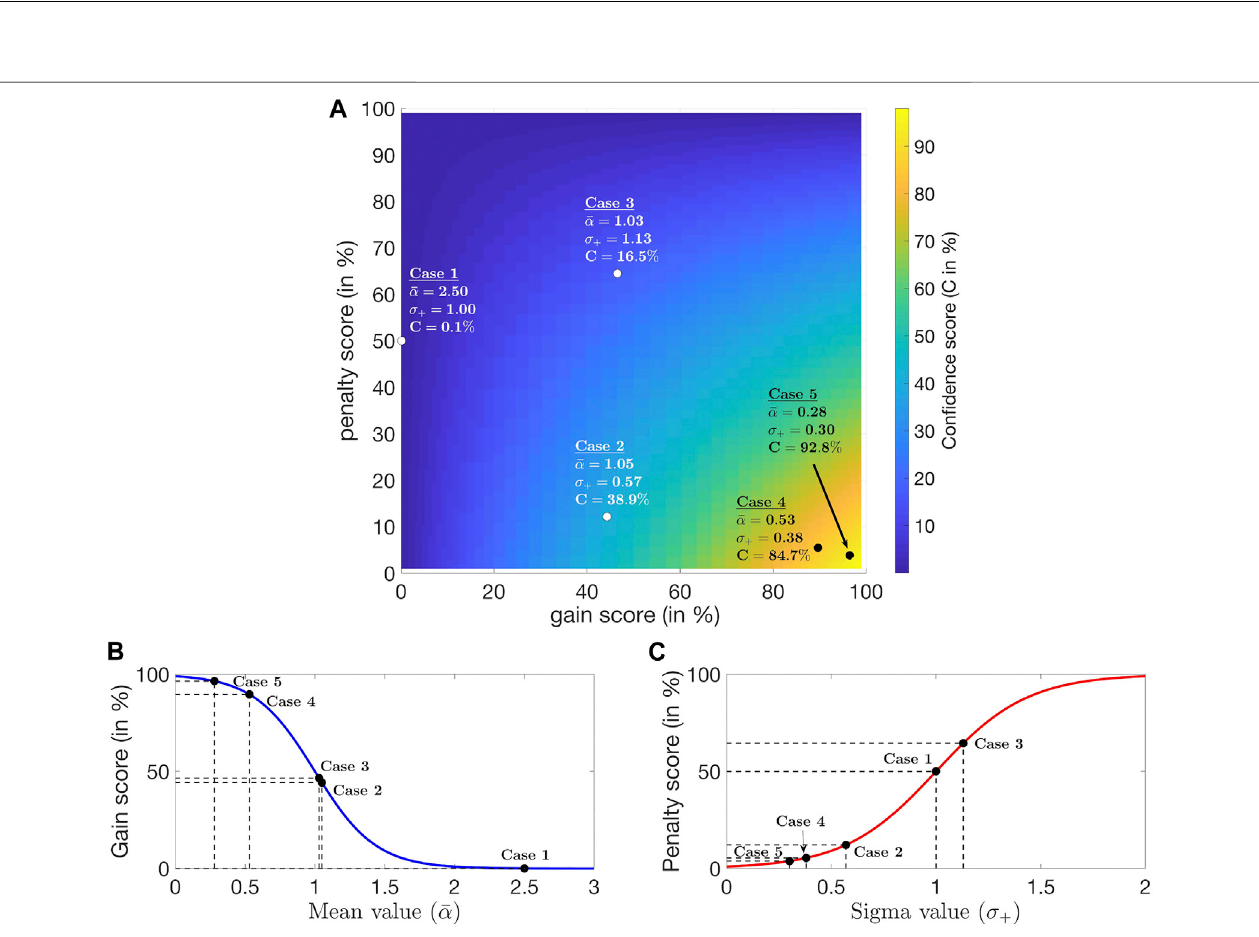
FIGURE4|(A) :2-Dcoloredmapofcon fi dencescores C asafunctionofboththegainandpenaltyscores. (B) and (C) :gainandpenaltyscoresasafunctionofthe mean value α and dispersion coef fi cient σ + . All scores are given as percentages. The fi ve cases already shown in Figure 3 are also annotated.